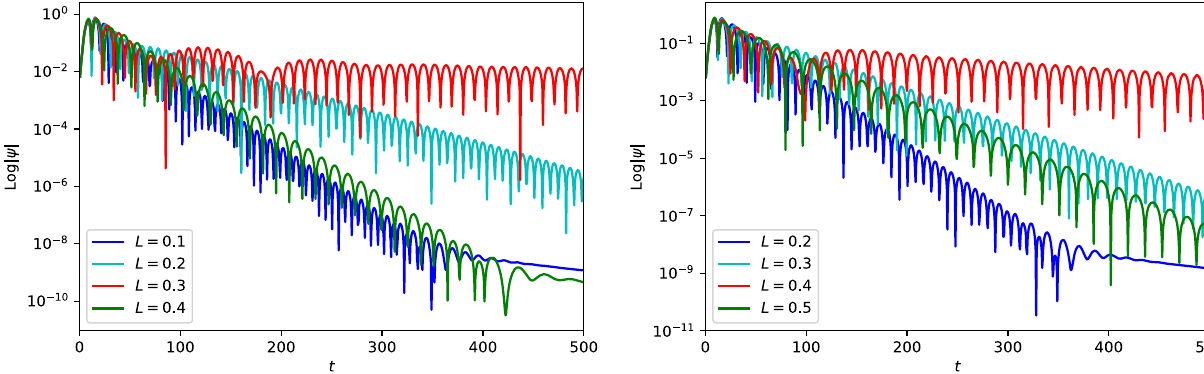
Fig. 13 Semilogarithmic plots for the time-evolution of electromagnetic field perturbation to black bounces in a cloud of strings with M = 0 . 5 , l = 1, a = 1 . 6 (left panel) and a = 2 (right